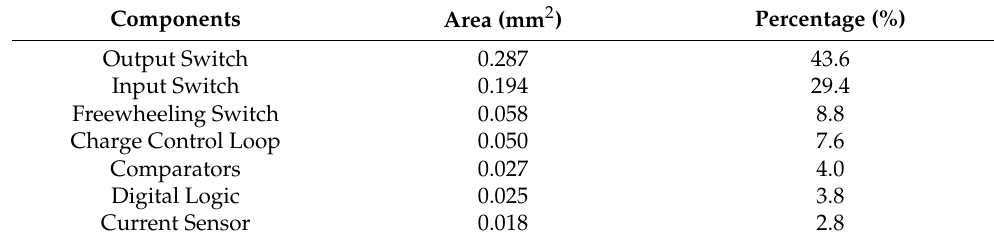
Table 1. Area breakdown of the proposed hybrid comparator-charge control SIMO DC-DC converter.